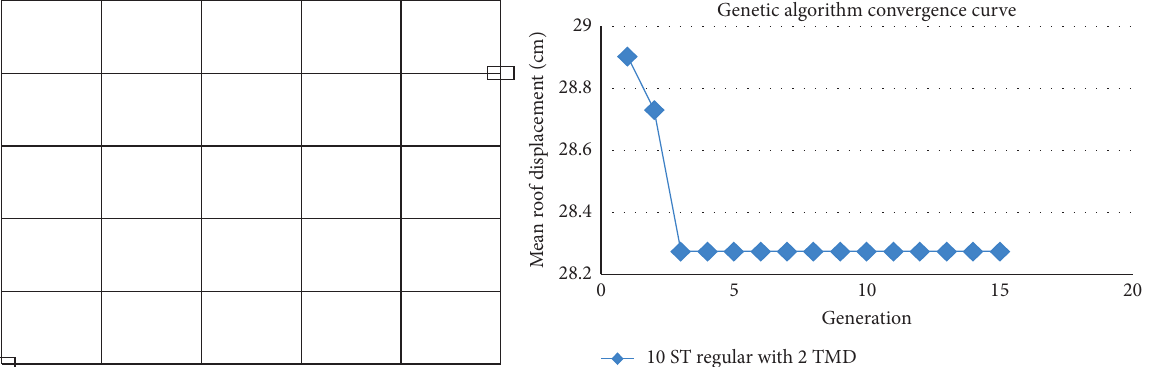
Figure 17: Convergence diagram of the ten-story model with 2 dampers in genetic algorithm (right) and damper optimal positions